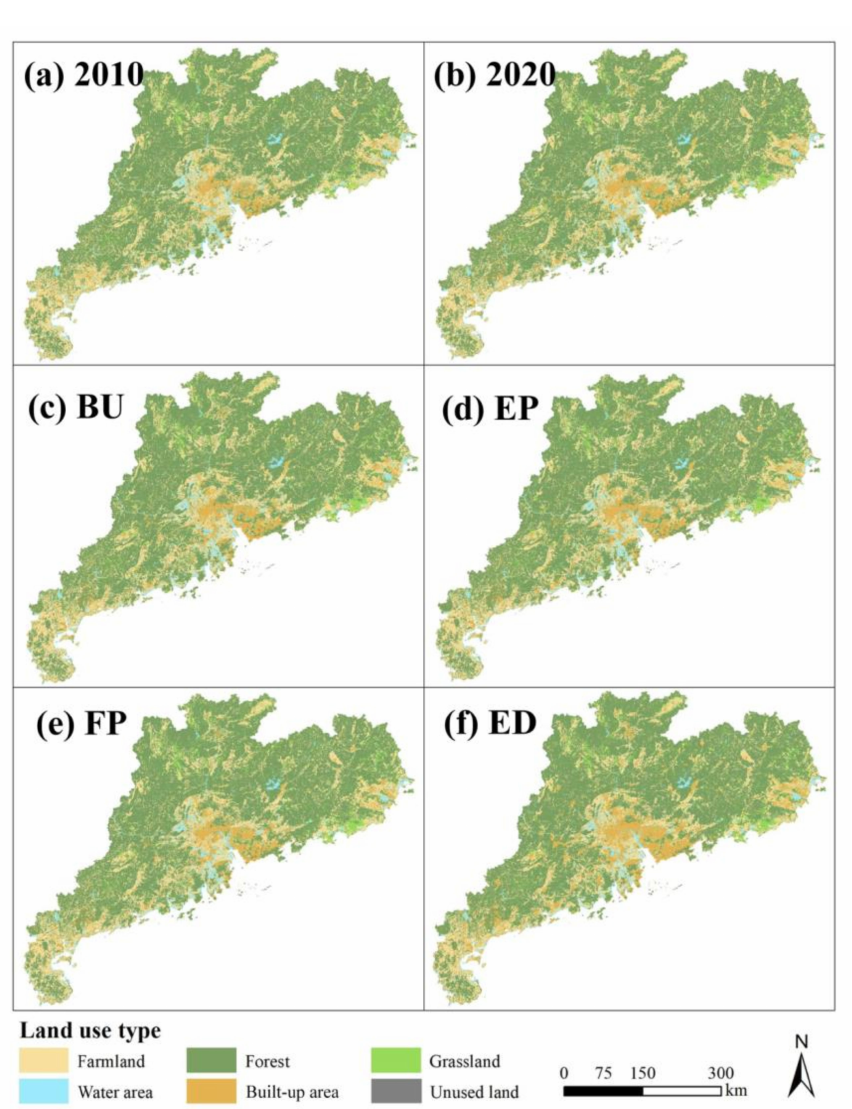
Figure 2. Spatial distribution of various land use types in ( a ) 2010, ( b ) 2020, and 2030 under ( c ) business as usual (BU), ( d ) ecological protection (EP), ( e ) farmland protection (FP), and ( f ) economic develop- ment (ED)